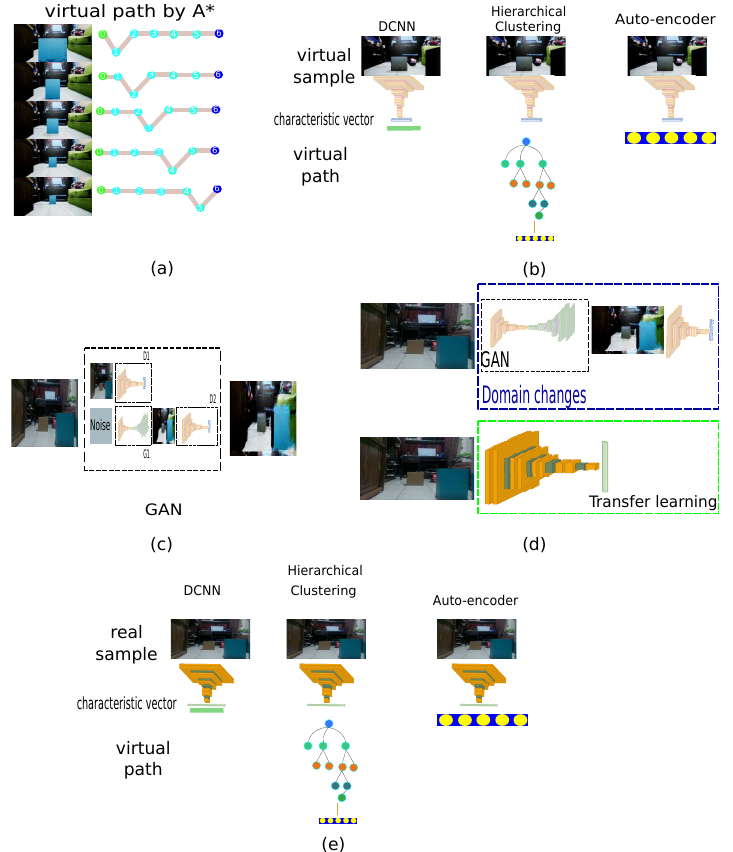
Figure 20. Interoperability between real and virtual environments by a GAN. ( a ) Each virtual sample has an associated virtual path based on A ∗ . ( b ) Three deep-learning solutions to estimate the virtual path. ( c ) GAN to connect the real and virtual domains. ( d ) Transfer learning approach to reduce the domain changes generated by the GAN. ( e ) The transfer learning model replaces each deep-learning solution with a few operations to estimate the characteristic vectors, connecting real samples to virtual